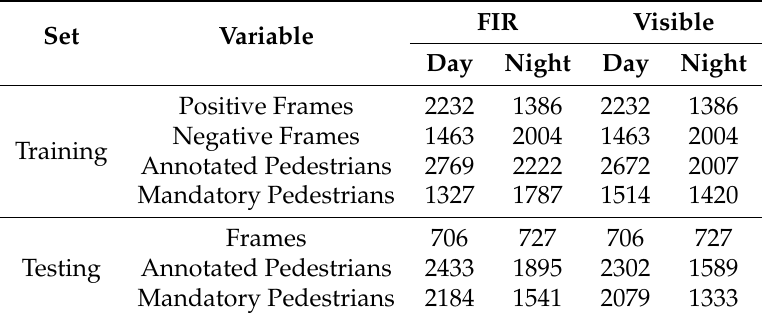
Table 2. New CVC-14 dataset summary of images and annotated